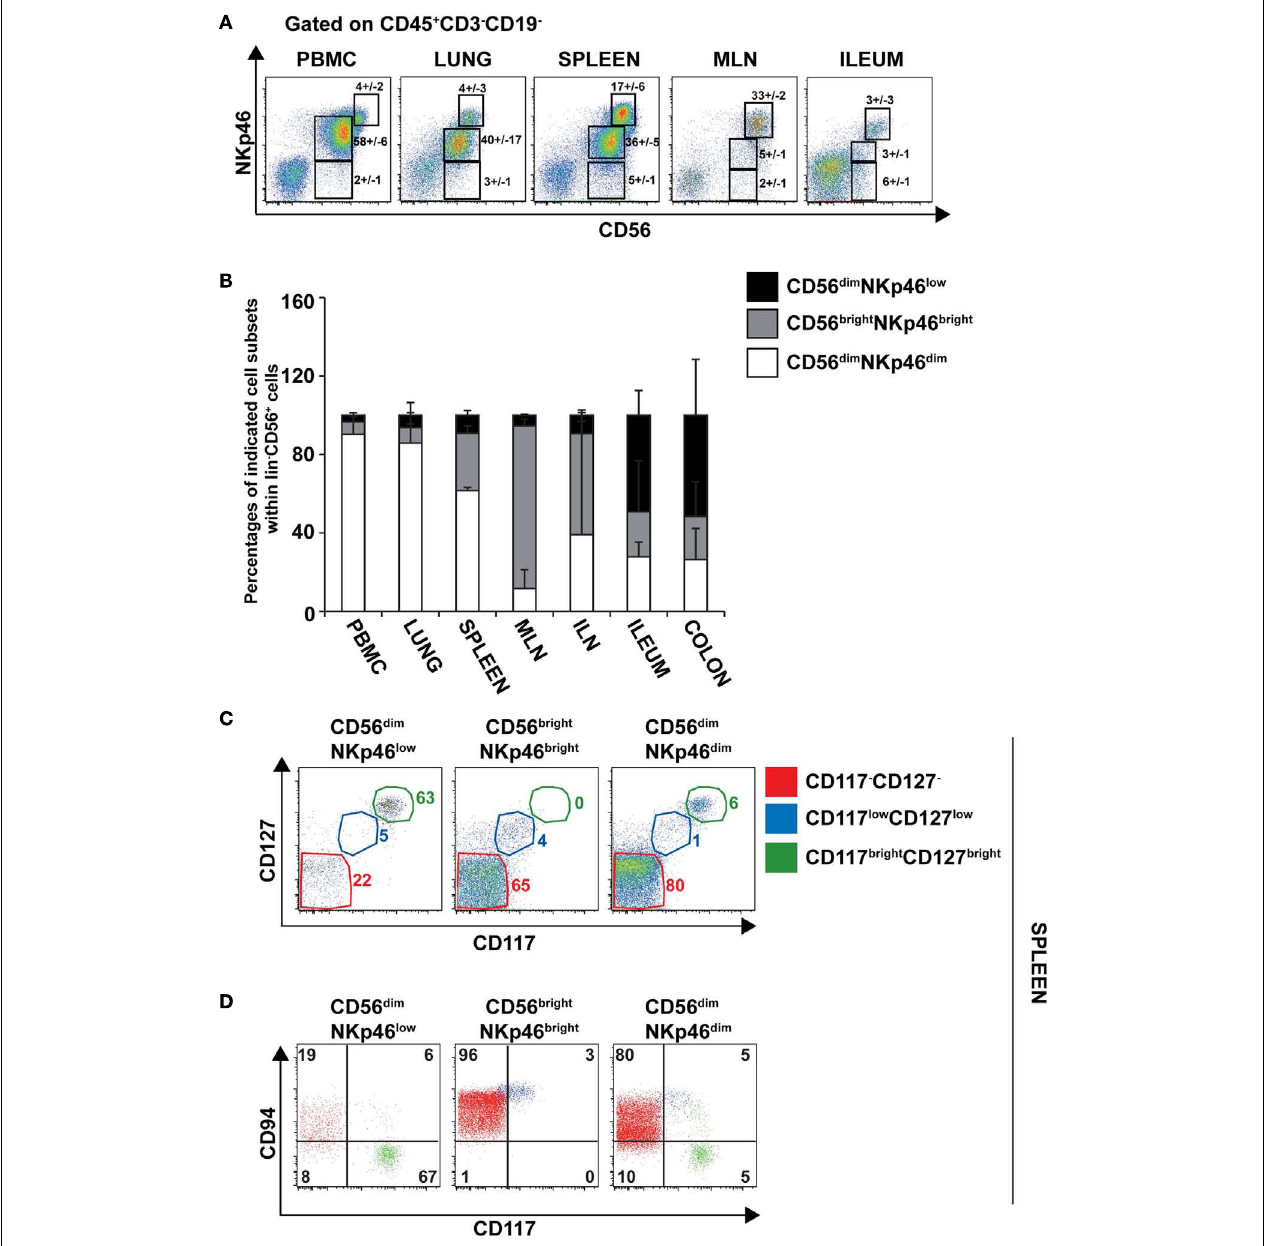
CD56 dim NKp46 low , CD56 bright NKp46 bright , and CD56 dim NKp46 dim cell subsets. Data are representative of at least three independent experiments. Red gate, CD117 − CD127 − cells; blue gate, CD117 low CD127 low cells; green gate, CD117 bright CD127 bright cells. (D) Flow cytometry analysis of CD94 and CD117 expression on indicated cell subsets of CD45 + CD3 − CD19 − splenocytes. Numbers in quadrants indicate percentages of cells. One experiment representative of three. Red cells were gated on CD117 − CD127 − cells; blue cells were gated on CD117 low CD127 low cells; green cells were gated on CD117 bright CD127 bright cells.